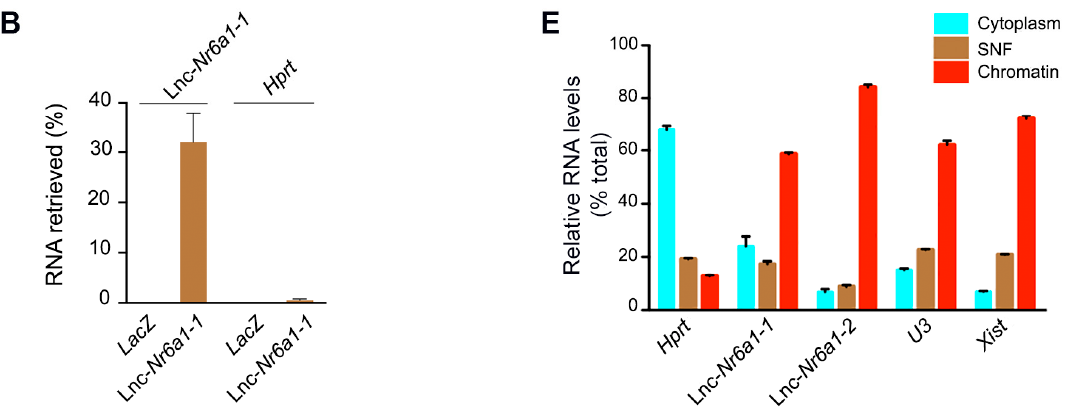
Figure 7. iDRIP-MS reveals direct lnc- Nr6a1-1 -interacting proteins. ( A ) A schematic overview of the iDRIP-MS method. ( B ) Retrieval of RNA by iDRIP using lnc- Nr6a1-1 and LacZ probes measured by RT-qPCR. Efficiency of lnc- Nr6a1-1 pulldown was determined by comparing to a standard curve generated using serial dilutions of input. Error bars S.D. ( C ) Selected lnc- Nr6a1-1 -interacting proteins identified by iDRIP are grouped into functional classes. ( D ) Physical association of lnc- Nr6a1-1 with Lamin A/C, g-catenin (Plakoglobin), ENO1, ALDOA and GAPDH was confirmed by RNA immunoprecipitation (RIP). ENO1, enolase; ALDOA, aldolase; GAPDH, glyceraldehyde 3-phophatedeshydrogenase. The results are the median of three technical replicates; error bars represent S.D. ( E ) Subcellular localization of lnc- Nr6a1 isoforms. Expression of Hprt , lnc- Nr6a1-1 , lnc- Nr6a1-2 , U3 and Xist in cytoplasmic, nuclear soluble and nuclear insoluble fractions of NMuMG cells. The graph is an average of three technical replicates; error bars represent